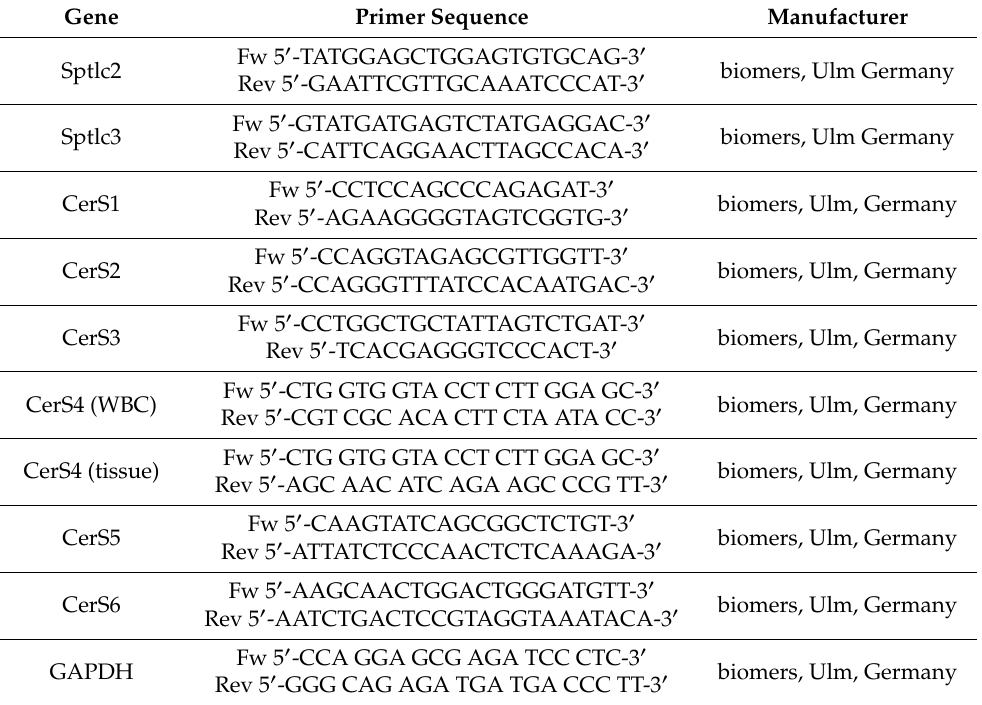
Table 1. qRT-PCR